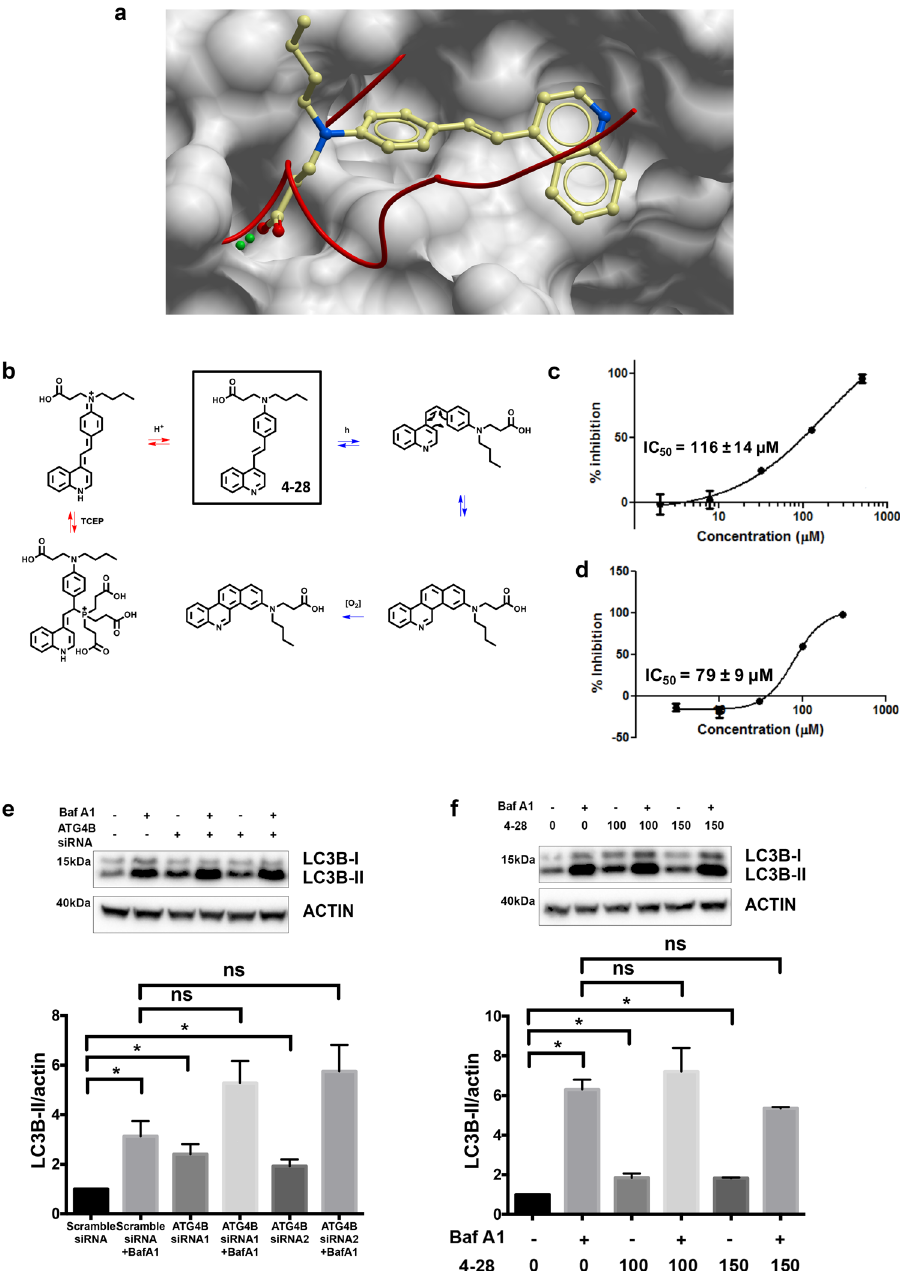
Figure 3. 4 – 28 inhibits ATG4B and blocks autophagic flux in cells. ( a ) Predicted binding model of compound 4–28 bound to ATG4B pocket closed#2. ( b ) Reactivity of 4–28 under UV irradiation affording the cis -isomer and hypothetically the cyclized form (blue pathway) and under TCEP treatment (red pathway). ( c ) Dose response curve of 4–28 obtained by mass spectrometry assay using GFP-LC3-YFP assay. n = 3; error bars, SEM ( d ) Dose response curve of 4–28 with fluorimetric assay. n = 3; error bars represent SEM ( e ) LC3B-based autophagy flux assay for ATG4B-siRNA. MCF7 cells treated with control scramble-siRNA, ATG4B-siRNA1, or ATG4B-siRNA2, in the absence or presence of bafilomycin A1 (Baf A1). n = 3; error bars, SEM; * p < 0.05. Full- length blots are presented in Fig. S1. ( f ) LC3B-based autophagy flux assay for 4–28 . MCF7 cells were treated with vehicle control or the indicated amounts of 4–28 , in the absence or presence of bafilomycin A1 (Baf A1). n = 3; error bars, SEM; * p < 0.05. Full-length blots are presented in Fig.